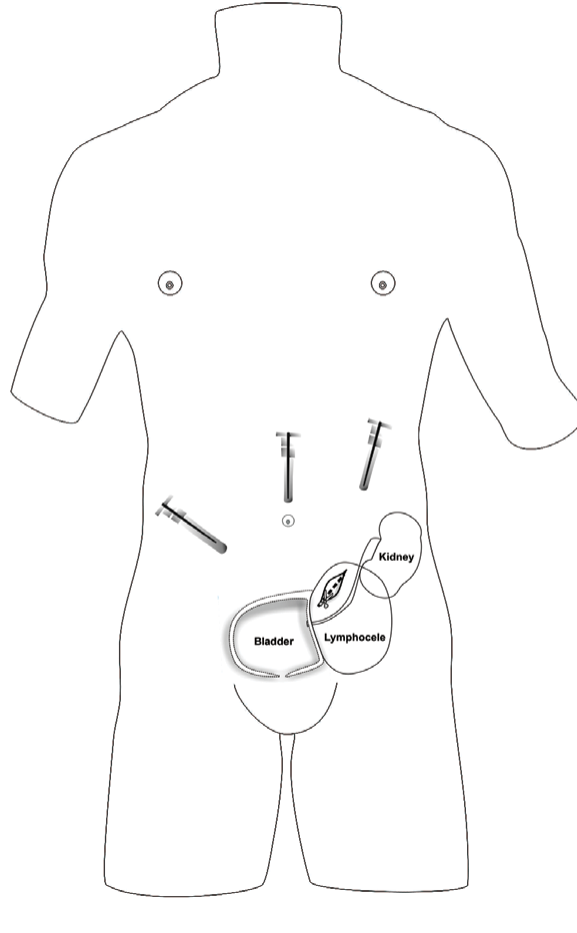
Figure 1 - Transperitoneal three-port position and lymphocele wall